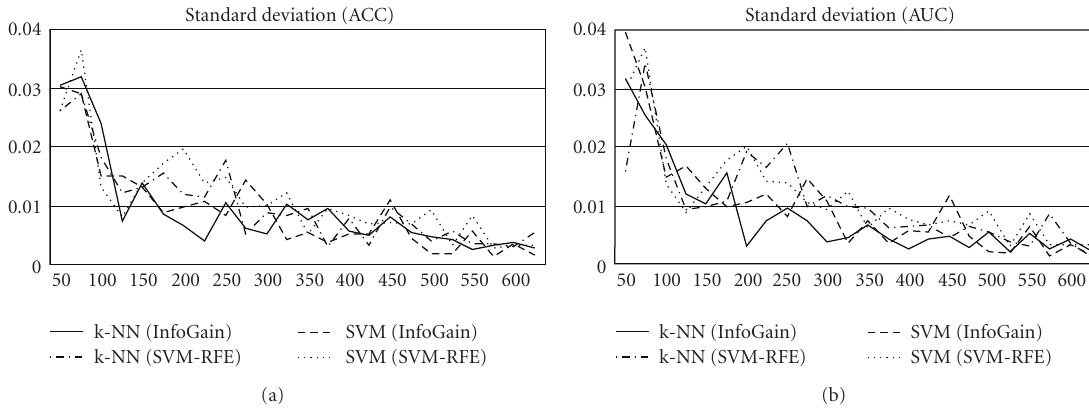
Figure 4: Standard deviation levels for classification accuracy and AUC (breast versus colon cancer dataset).